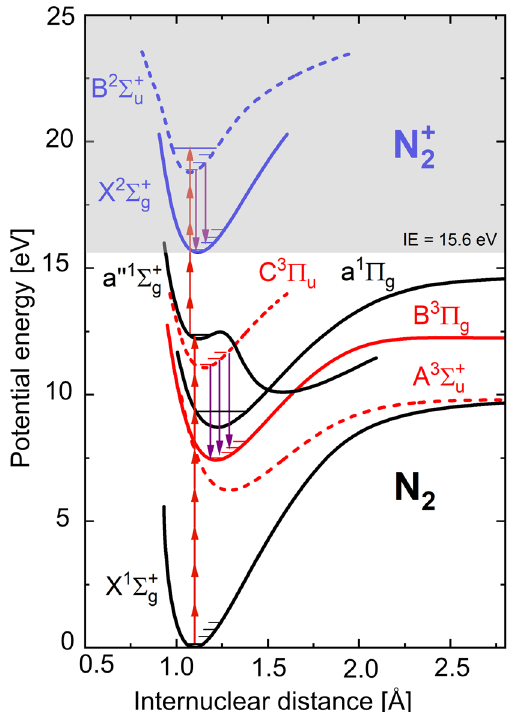
+ Figure 2. Electronic structure of N 2 and N 2 , where the ionization energy (IE) is indicated. The energy of an 800 nm photon (1.55 eV) is indicated by a red arrow and the purple arrows show the fluorescence. The potential curves are based on data reported by Western et al. 31 , Ermler et al. 32 , and Singh and Rai 33